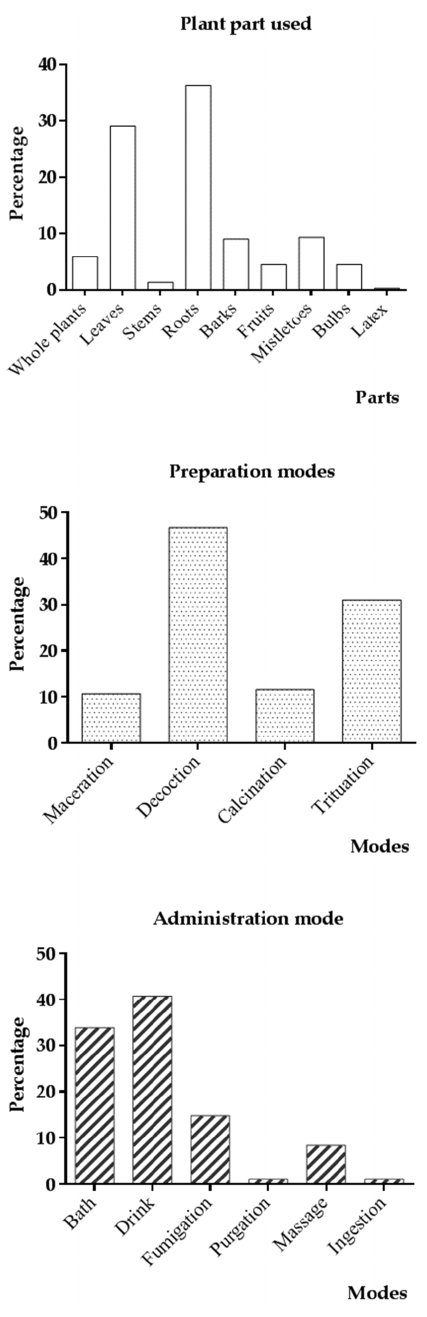
Figure 2. Plant parts used, modes of preparation and administration of remedies. Table 3. Pathologies treated, traditional healers (TH) rate and medicinal plants